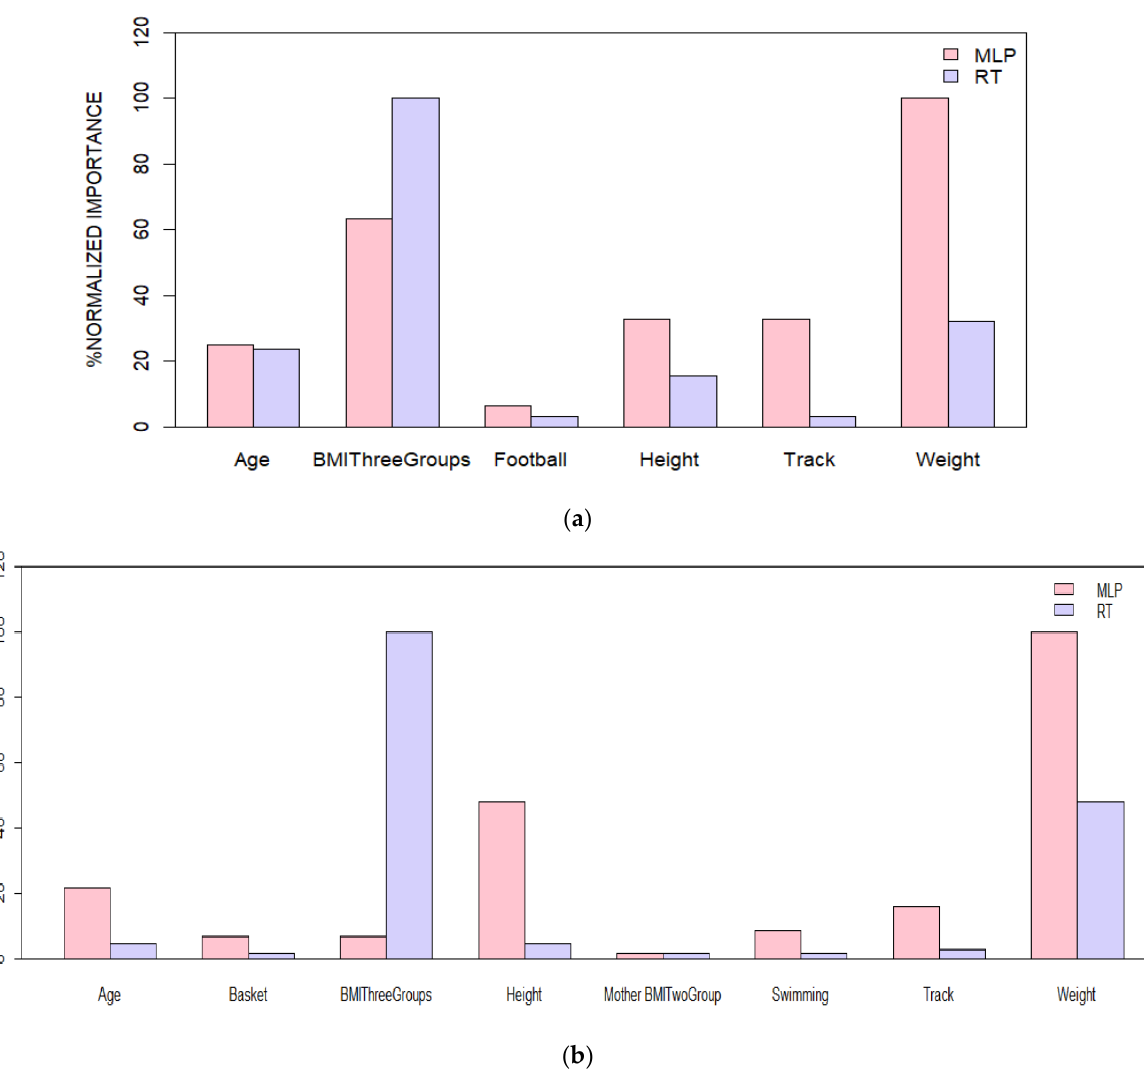
Figure 8. Variable importance (normalized). MLP and RT models for ( a ) boys and ( b ) girls, with the percentages of normalized importance for MLP and RT for both boys and girls.